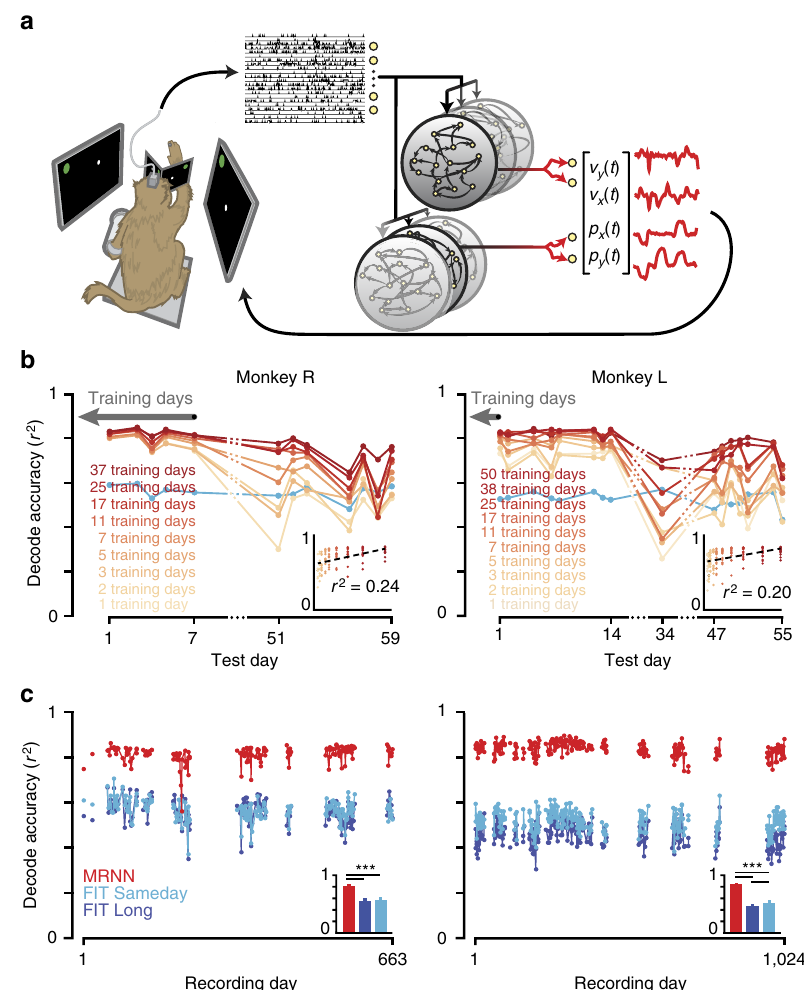
Figure 2 | An MRNN decoder can harness large training data sets. ( a ) A monkey performed a target acquisition task using his hand while multiunit spikes were recorded from multielectrode arrays in motor cortex. Data from many days were used to train two MRNNs such that velocity and position were read